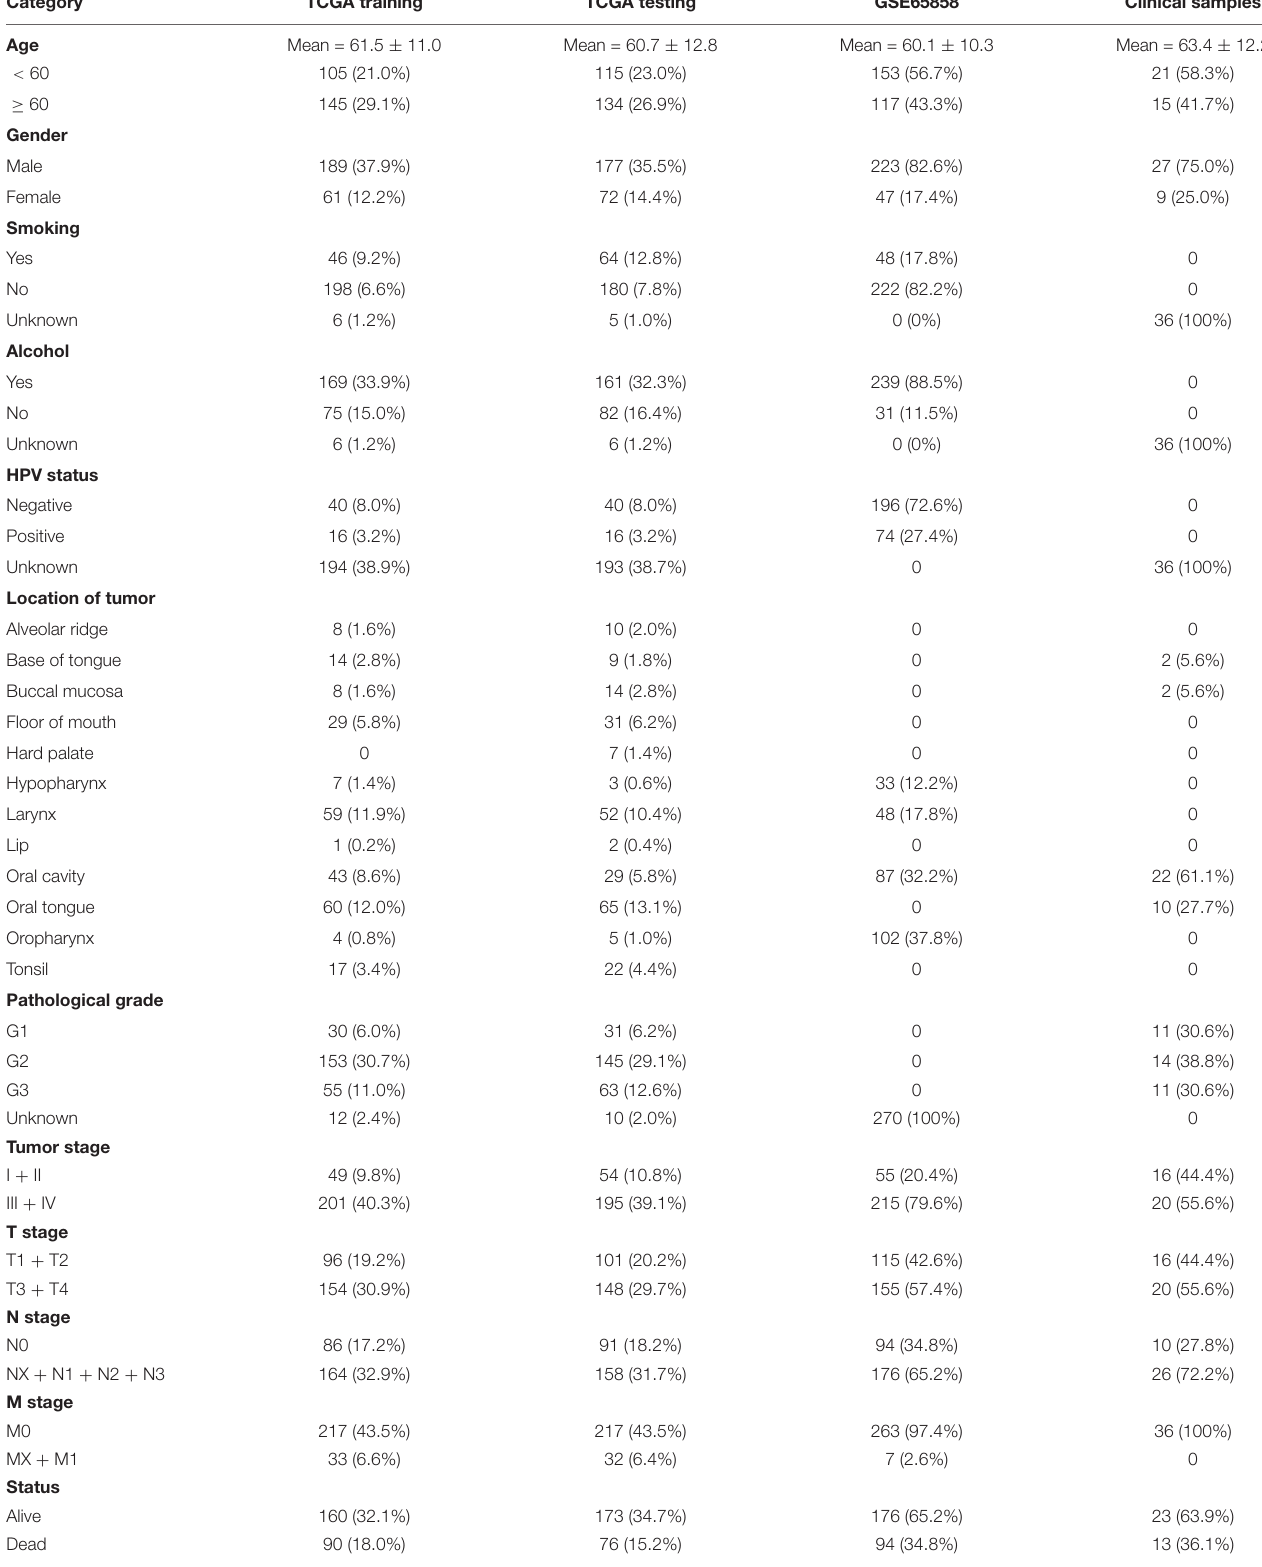
TABLE 5 | Clinical data of TCGA-HNSC, GSE65858, and clinical